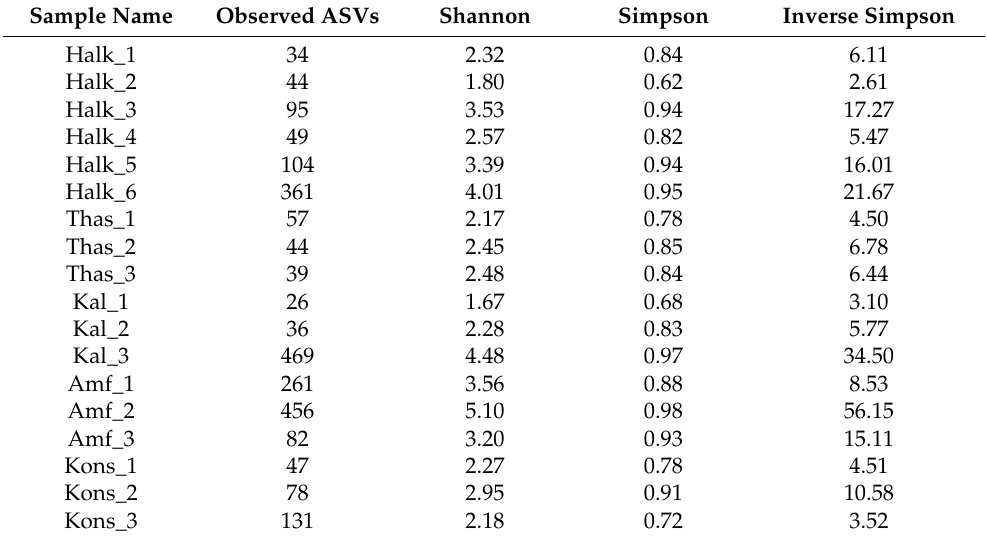
Table 2. Number of ASVs (amplicon sequence variants) and alpha diversity indices for each sample based on 16S rRNA amplicon